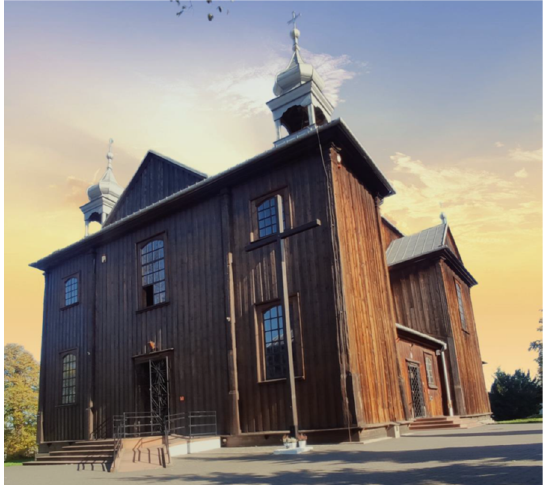
Figure 1. View of the church of St. Szczepan in Mnichów (source: private archive).